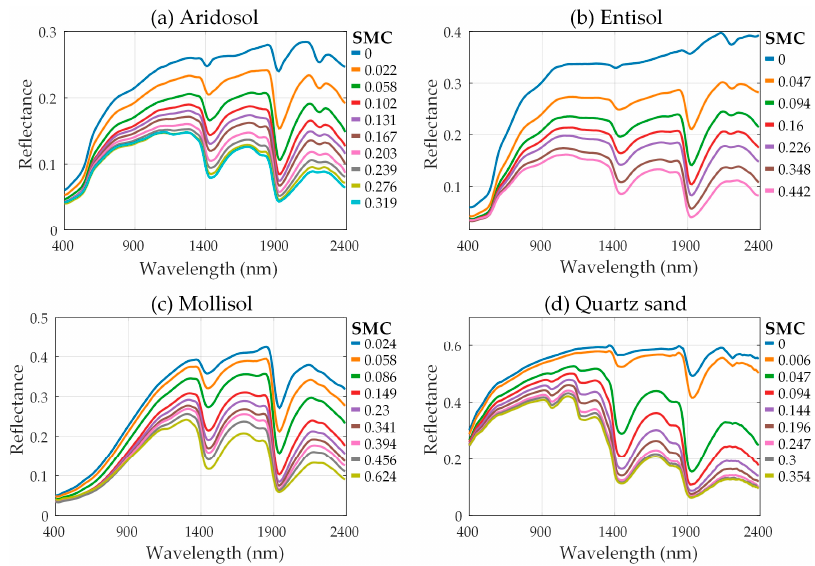
Figure 4. Spectral reflectance of the four soil samples under various levels of volumetric soil water content.